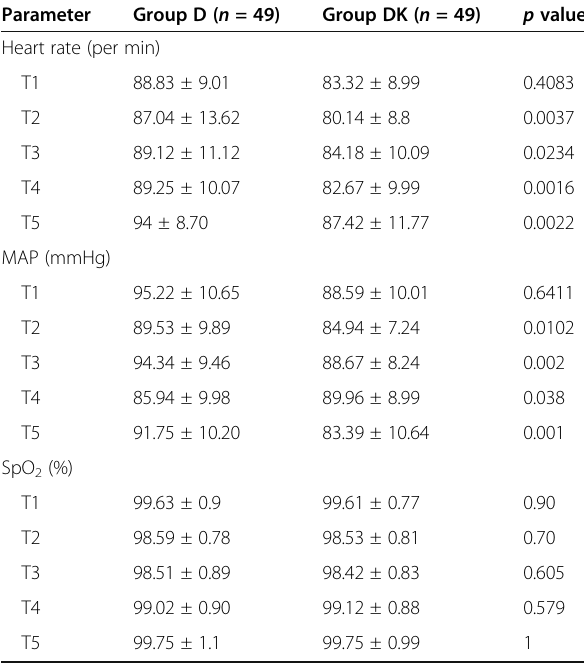
Table 4 Comparison of haemodynamic parameters